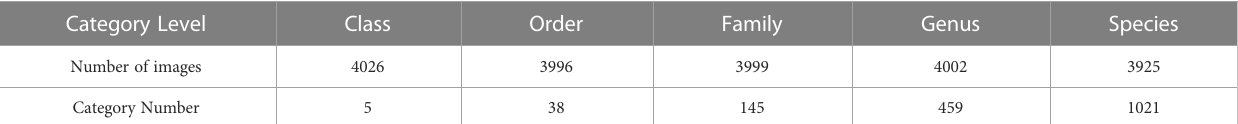
TABLE 1 The number of images for the fi ve taxonomic